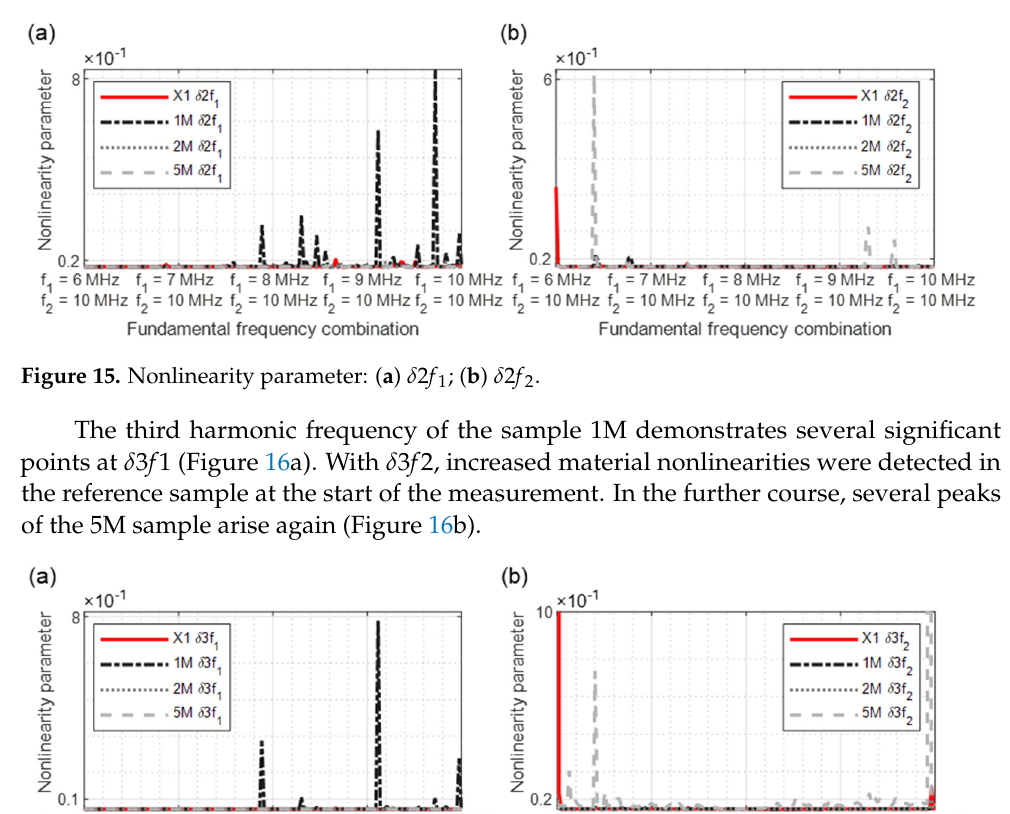
1 = 6 to 10 MHz, f 2 = 10 MHz.